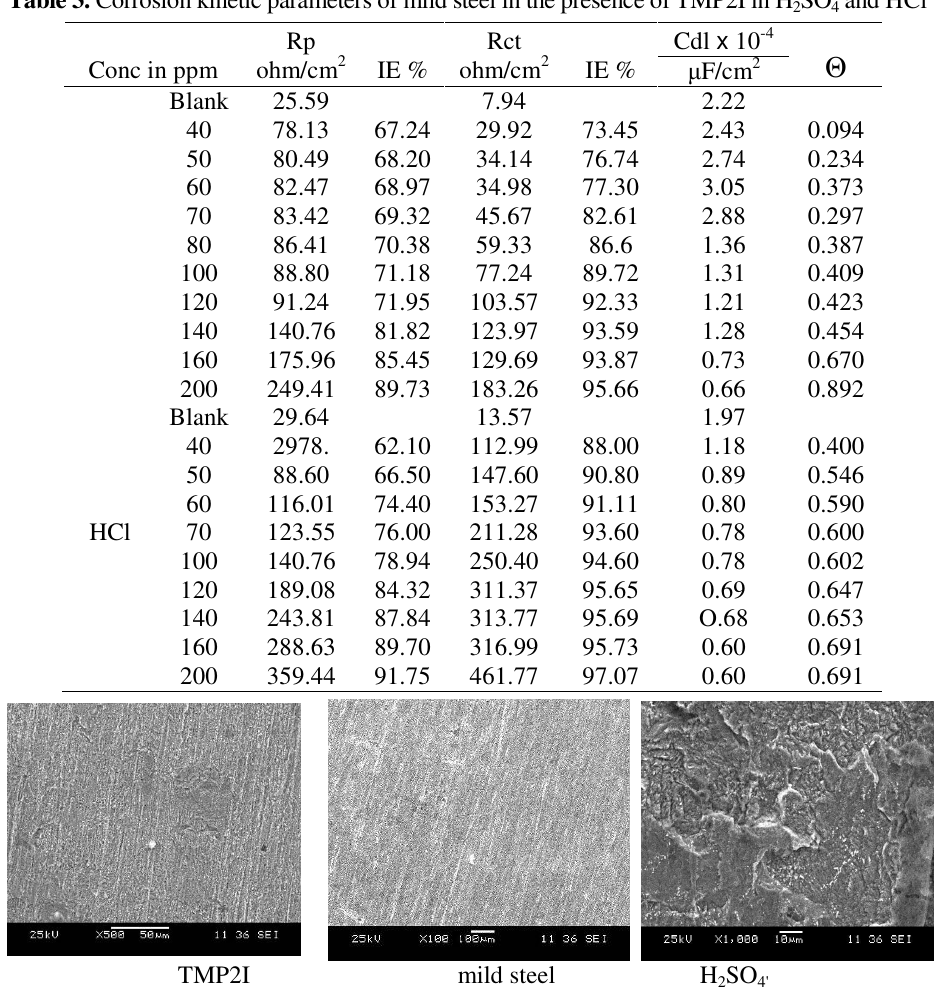
Figure 6. SEM of TMP2I, mild steel and mild steel dipped in H